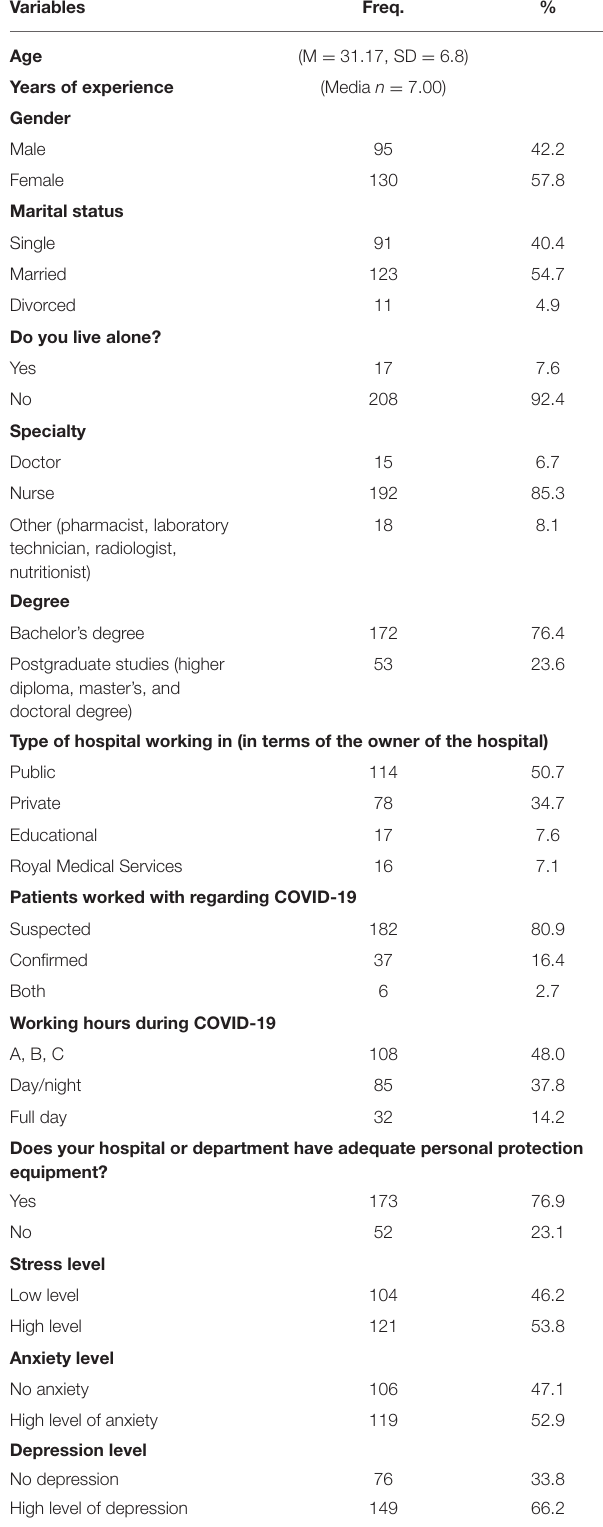
Table 1 | Characteristics of the participants (* n =